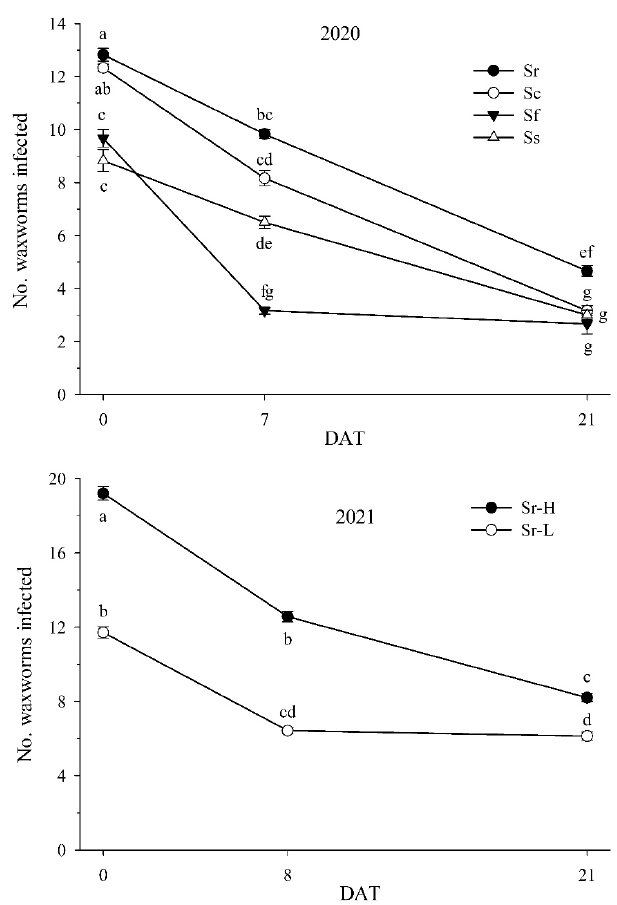
Figure 6. Persistence of the entomopathogenic nematodes Steinernema carpocapsae (Sc), S. riobrave (Sr), S. feltiae (Sf), and S. scarabaei (applied at 50 infective juveniles per cm 2 ) in the 2020 field experiment ( top ) and of S. riobrave applied at a low (-L; 25 per cm 2 ) and high (-H; 50 per cm 2 ) rate in the 2021 field experiment ( bottom ). Persistence was determined by saturation baiting with waxworms of 100 g soil samples taken from the field plots 0 to 21 days after treatment (DAT). Letters next to symbols indicate significant differences in the total number of waxworms ( p <